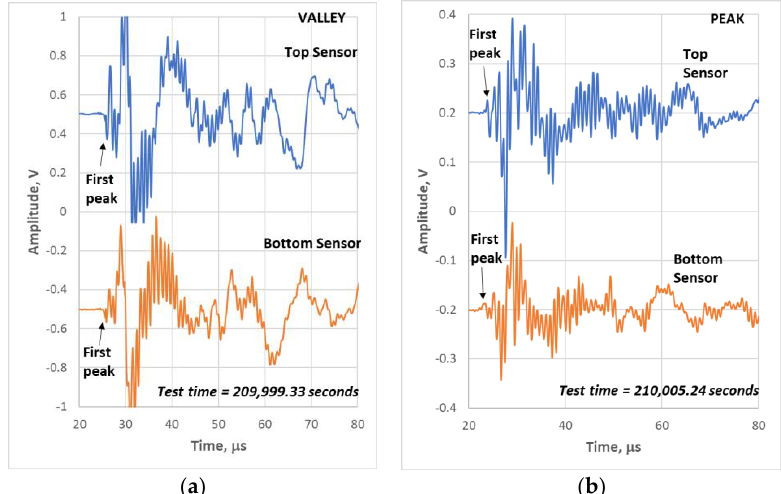
Figure 6. Waveforms from top and bottom sensors for: ( a ) a valley event; and ( b ) a peak event showing the first peaks of each waveform from 113-3.